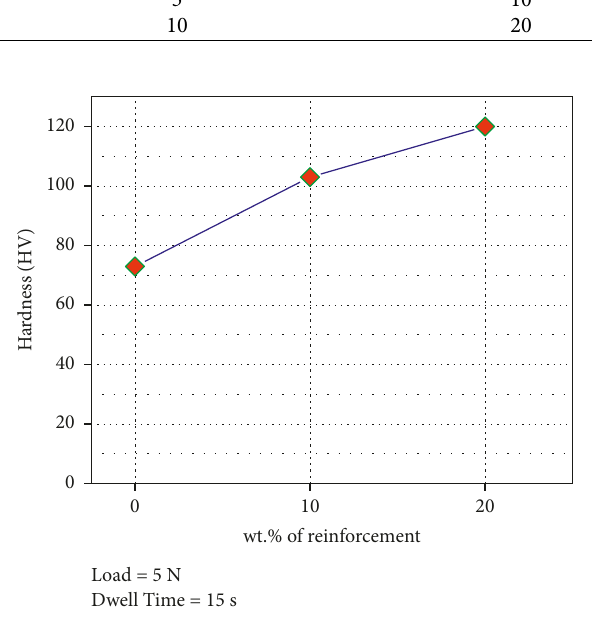
Figure 2: Effect of reinforcement on the hardness.